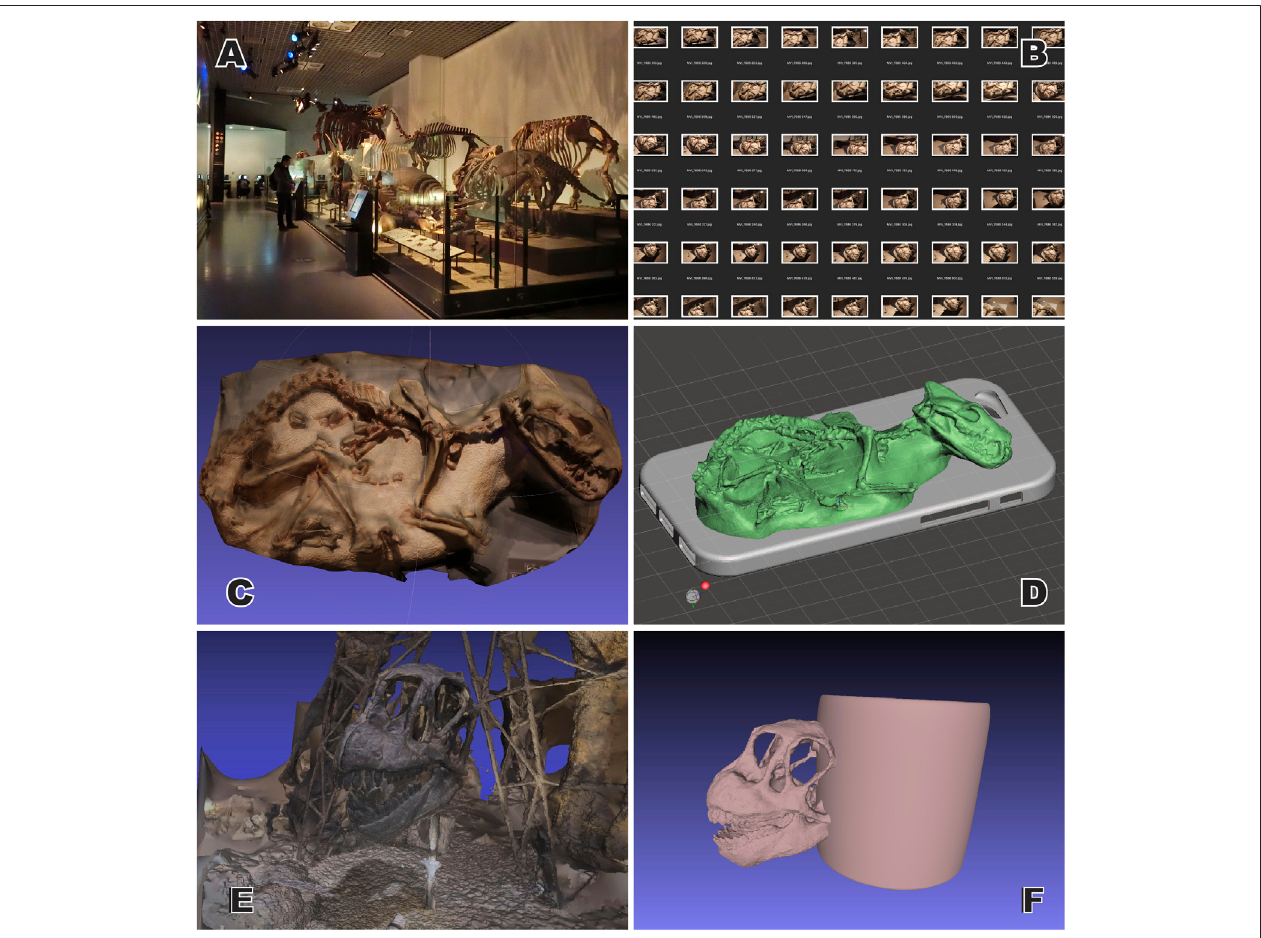
FIGURE 3 | Photogrammetry-based 3D models of the Hyaenodon and Camarasaurus skulls and their virtual products. (A) Exhibition gallery at the National Museum of Nature and Science, Tokyo, Japan. Fossils were displayed behind glass walls. Lighting conditions change from dawn to twilight; and, walkways were dimmed. Theseconditions aregenerallynot ideal forphotogrammetry (Agisoft, 2018). (B) Photos of Hyaenodon displayed ina permanent exhibition gallery. Thesewere taken under museum photo policies and later used to create a photogrammetry-based 3D model. (C) Photogrammetry-based 3D model of Hyaenodon . It was constructed using the Agisoft Metashape (Agisoft, 2018). (D) Original smartphone cover as a virtual product made using the Hyaenodon model. (E) Photogrammetry- based 3D model of the Camarasaurus skull. It was constructed using the Agisoft Metashape (Agisoft, 2018). (F) Original mug as a virtual product made using the Camarasaurus skull model. We merged the Camarasaurus skull model and a 3D model of a mug in the Meshmixer (Autodesk, 2017).